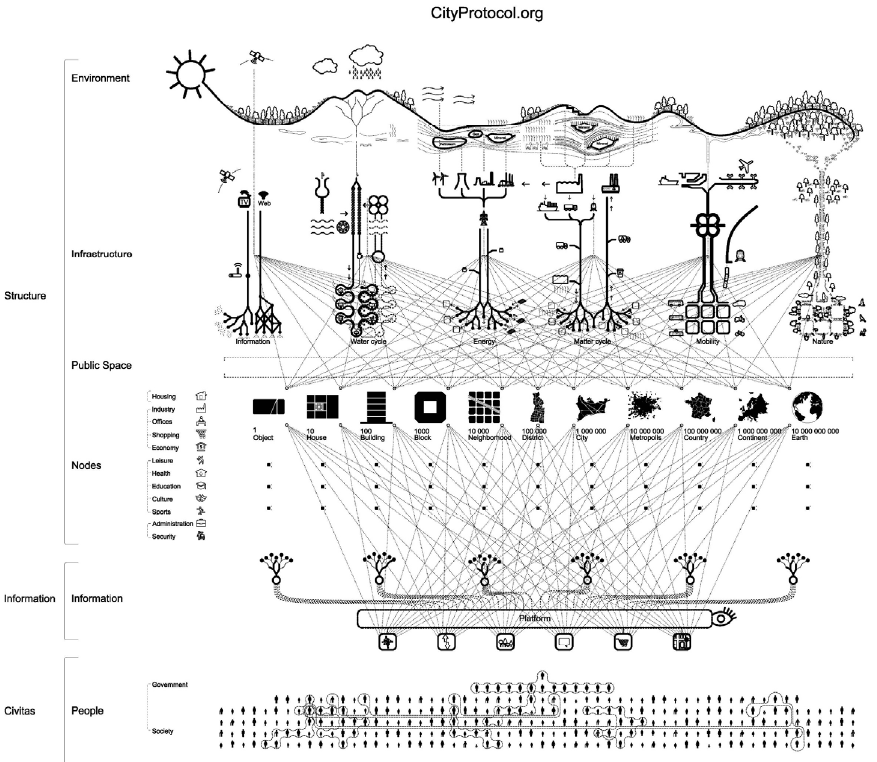
Figure 1. Bird’s-eye view of the City Protocol Society’s City Anatomy. Source: City Protocol Society.